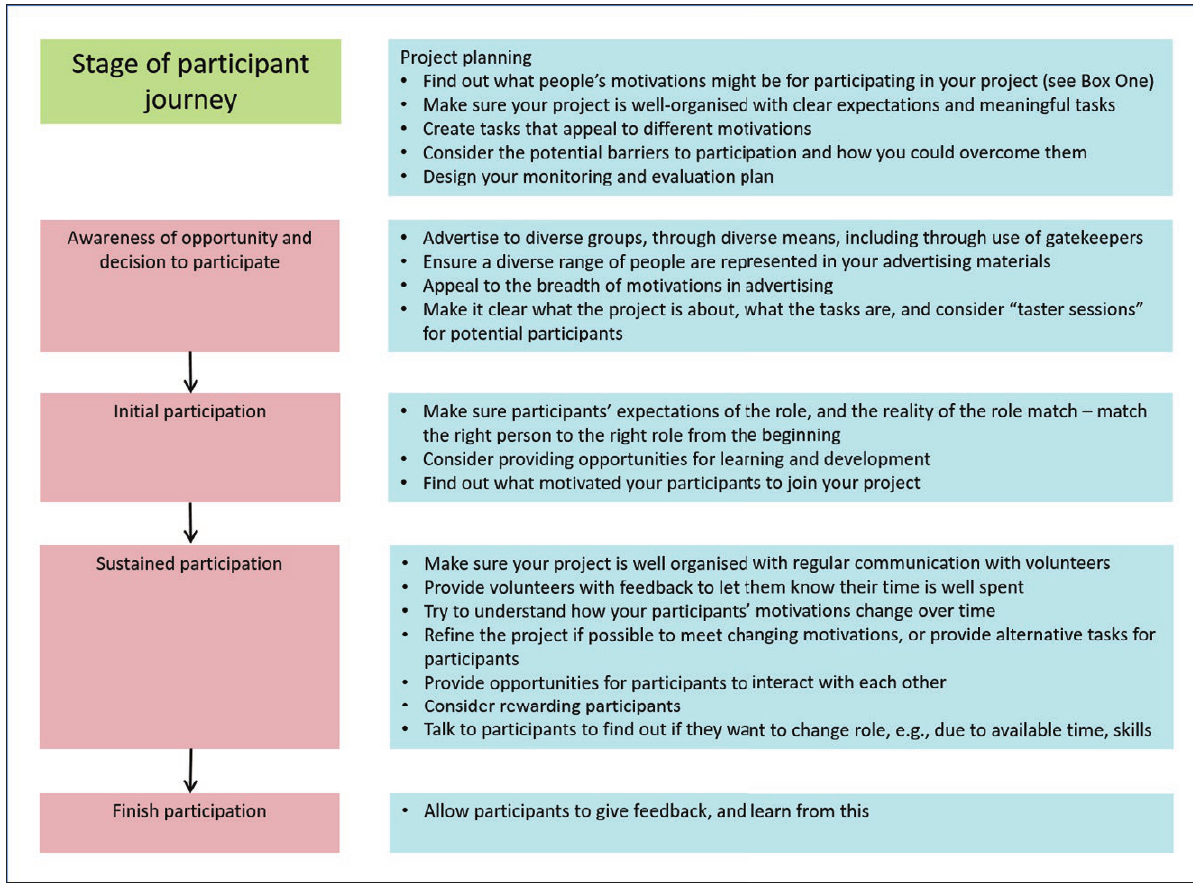
Figure 1: The journey that a participant takes when participating in a project (left side), with a checklist for project organisers corresponding to each of these stages (right side) to maximise the changes of people having a positive experience of